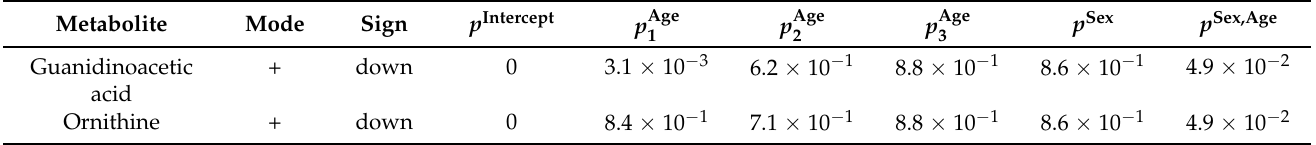
Table A4. Significant (corrected p -value p Sex,Age < 0.05) interaction of age and sex related metabolites for BC-Metchalizer normalized data. An “up” in column “Sign” indicates that the metabolite was increased in women and vice versa. Slashes in the names indicate that chromatographic separation was not